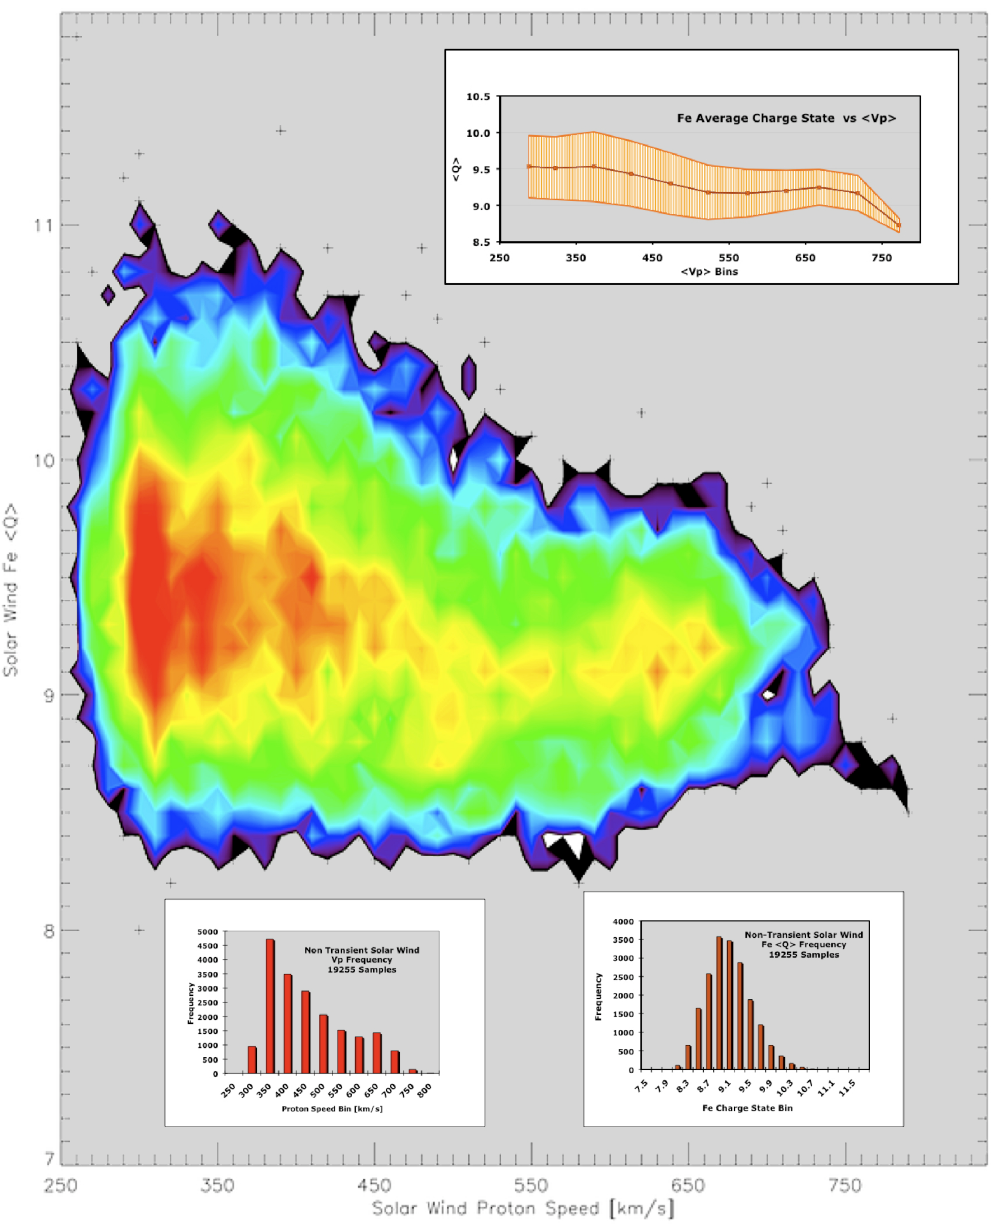
Fig. 5. Same data as Fig. 3, but the identified transient periods have been removed and the data are displayed as a contour plot in number of samples. The non-transient event data set constitutes over 19255 one-hour samples of fast and slow solar wind. Shown as inserts are: (Top) the average iron charge state per velocity bin with ± 1-sigma of the population as a function of solar wind speed. (Bottom left) Frequency distribution of solar wind speeds, 50km/s binning. (Bottom right) Frequency distribution of Fe average charge states, 0.25